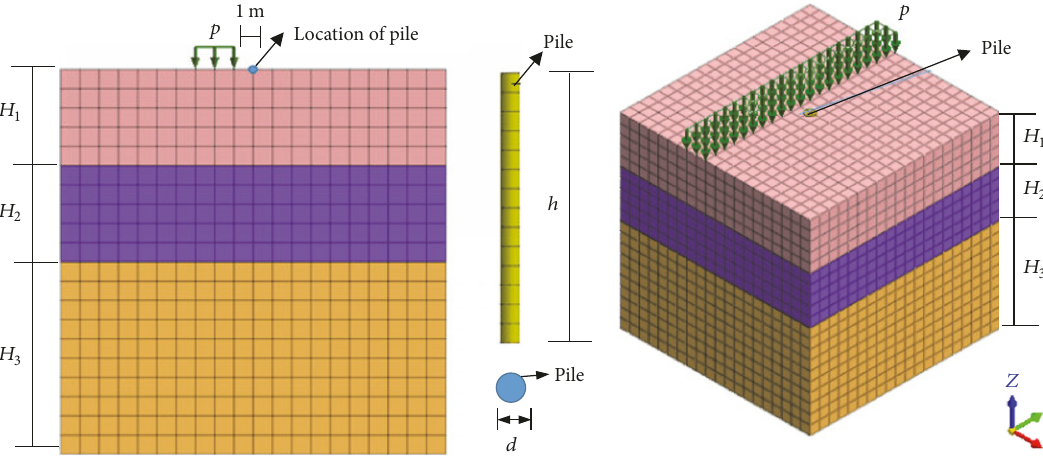
Figure 2: Numerical model of pile and soil.